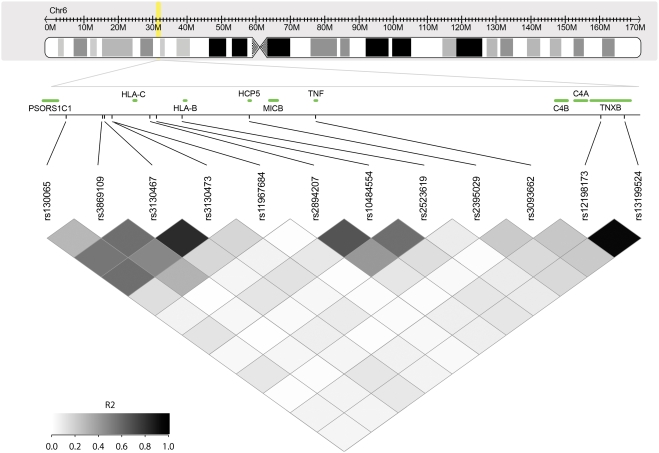
Location of the twelve selected SNPs in the MHC region (6p21) and linkage disequilibrium plot.Upper box shows an ideogram depicting chromosome 6 and the annotated region (transparent yellow rectangle). Lower box shows the linkage disequilibrium data matrix calculated from the European HapMap population. The colour intensity of each box is proportional to the strength of the LD property (r2) for the marker pair.